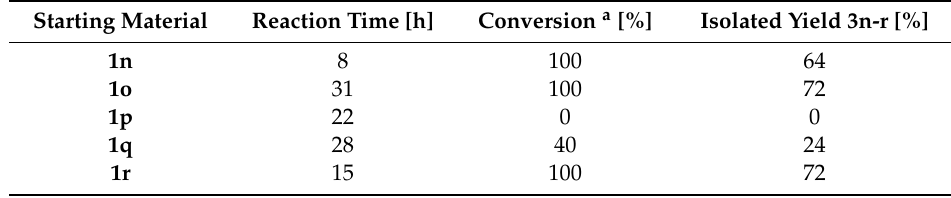
Table 4. Photocyclization of N-aryl imines 1n-r .